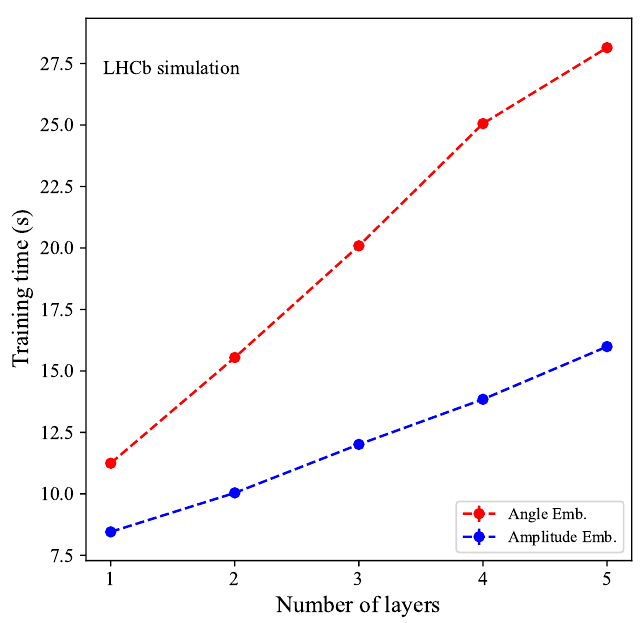
Figure 10. Training time for 100 epochs for (red) the Angle Embedding and (blue) Amplitude Embedding circuits on the muon dataset with respect to the number of circuit